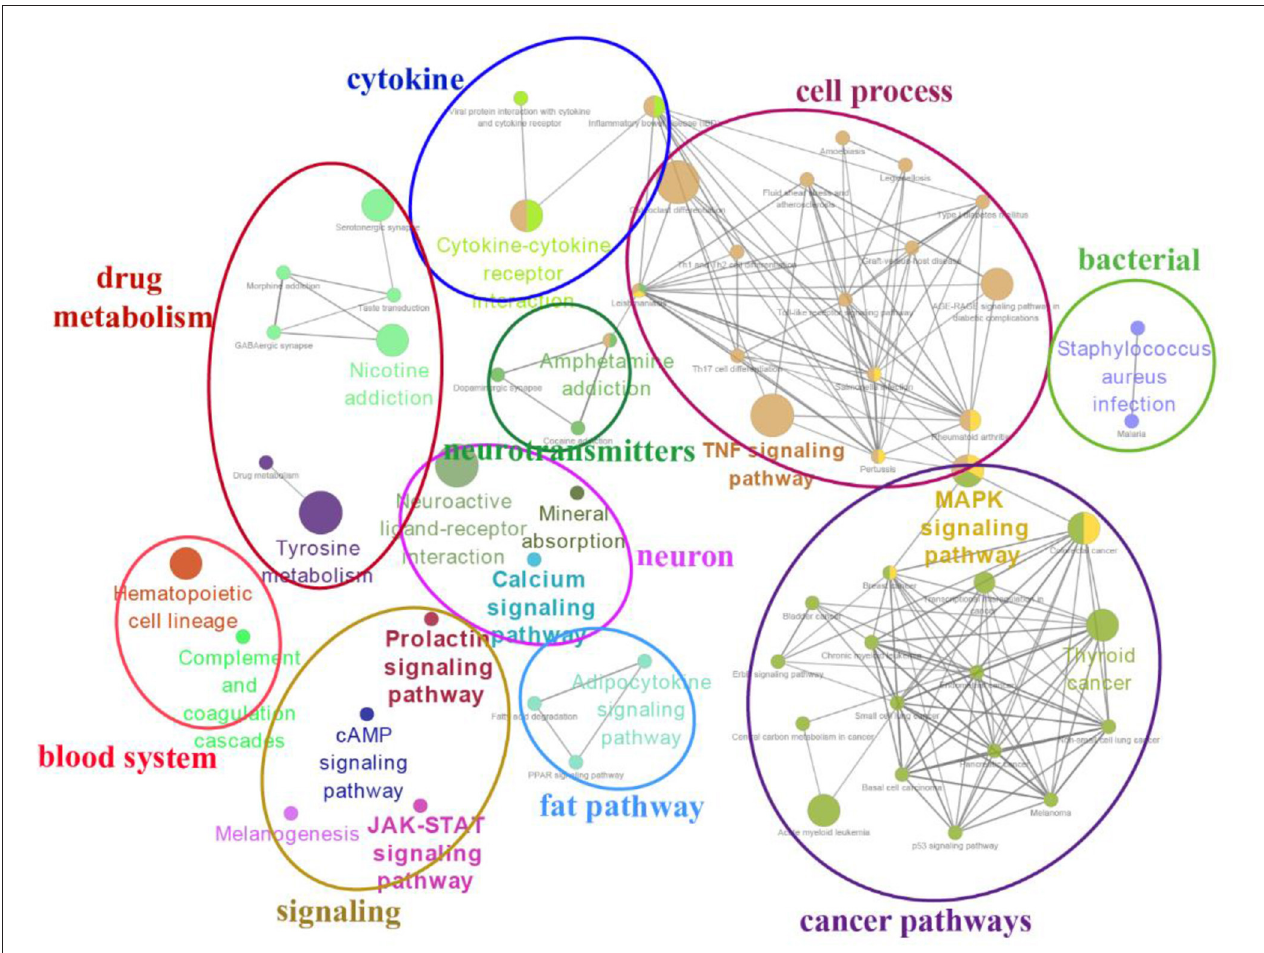
FIGURE 7 | A simplified network of related statistically KEGG pathways using the Cytoscape add-on ClueGO (34, 35). The network of overlap DE genes among SP21 vs. LP7, LP21, and LP42 are shown. The filled colored circles (nodes) represent each statistically parent KEGG pathway. The lines (edges) between the nodes show that there are overlapping genes within each pathway. The colored ovals group these parent KEGG pathways into more generic functional